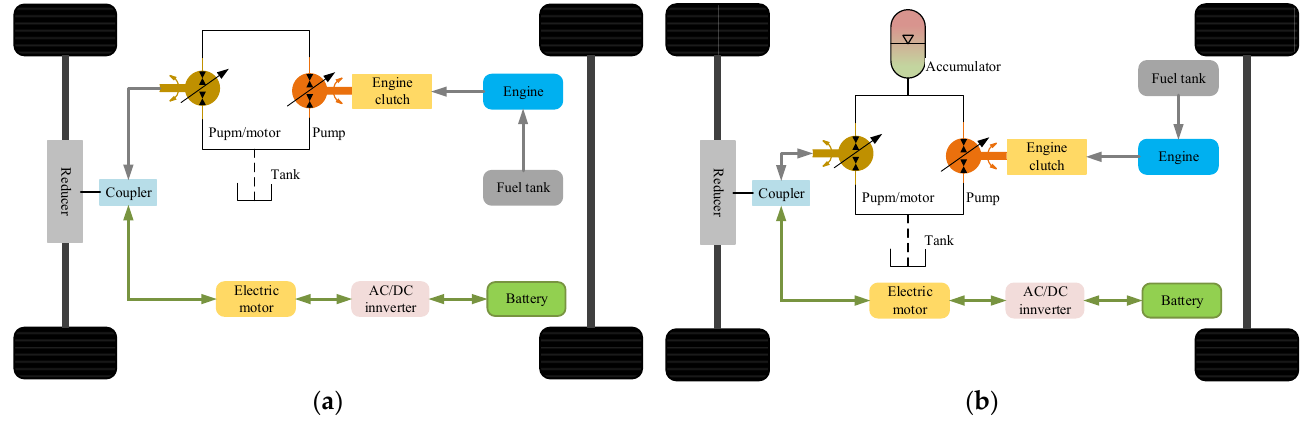
Figure 12. Evolution project of hybrid hydraulic BUSINOVA bus: ( a ) block diagram of the ICE- electric hybrid power flows; ( b ) block diagram of the ICE–electric–accumulator–actuated powertrain power flows [40,89,90].